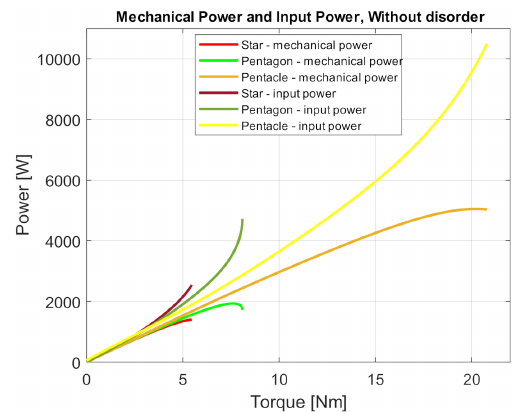
Figure 7. Power and power input depending on load torque, fault-free state, U IN = 5 × 230 V, 50